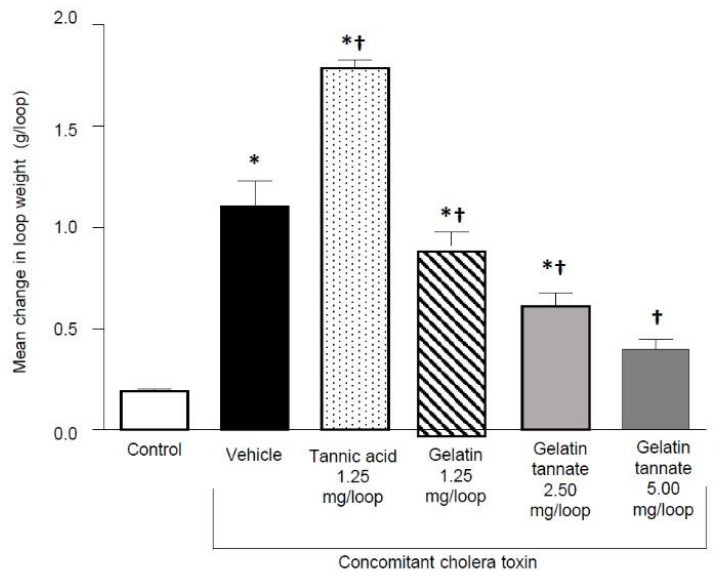
Figure 2. Local (intra-jejunal loop) administration of gelatin 1.25 mg/loop and gelatin tannate 2.5 mg/loop or 5.0 mg/loop significantly attenuated mean cholera toxin-induced water secretion relative to vehicle in isolated jejunal loops of anesthetized rats ( n = 8/group). * p < 0.05 vs. control, † p < 0.05 vs. vehicle.